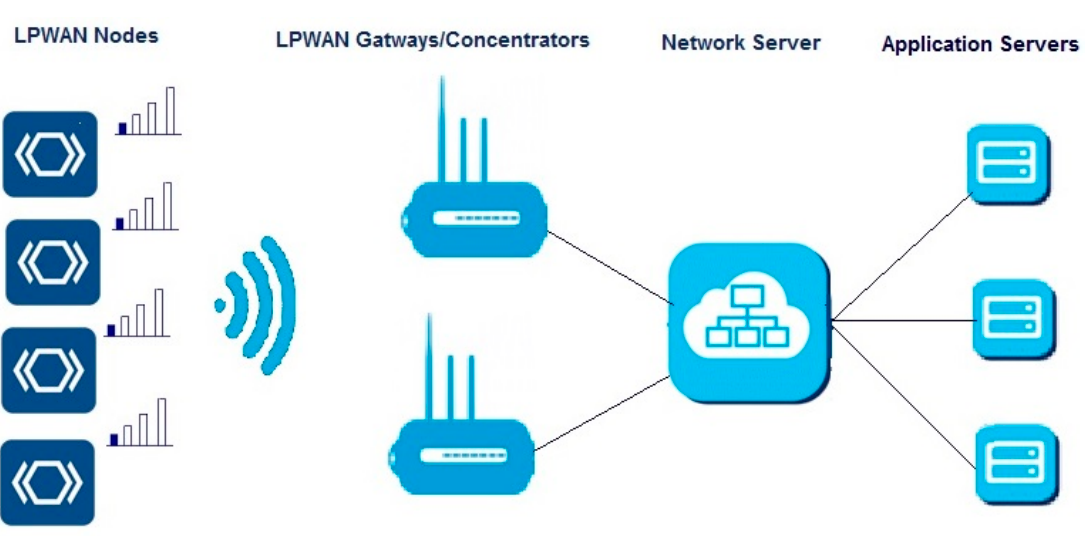
Figure 3. ( a ) Star topology, ( b ) mesh network topology.